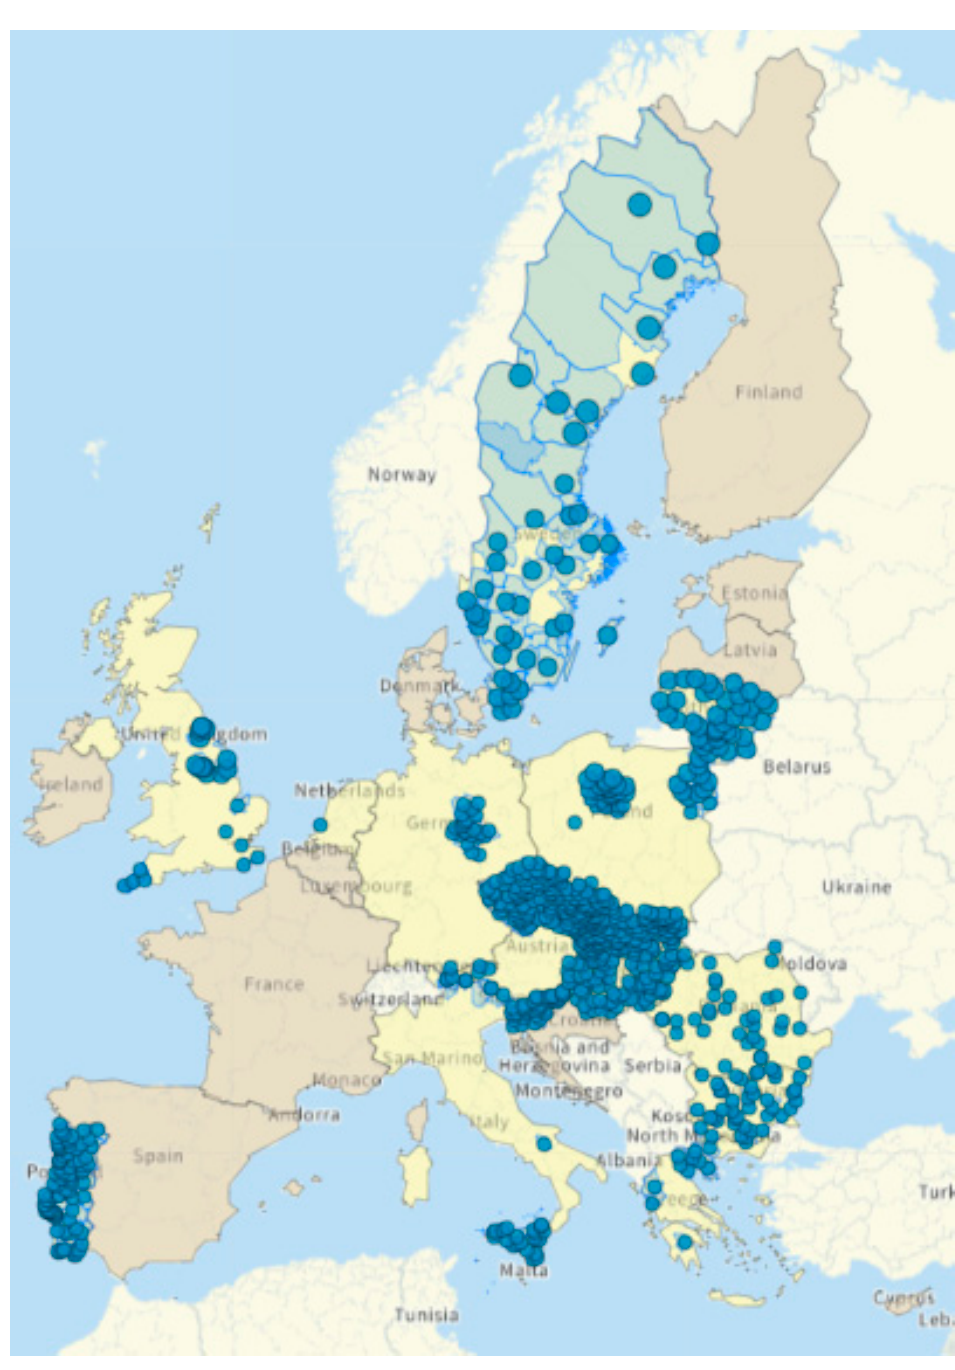
Figure A1. Map of cohesion policy-funded CLLD LAGs in 2014–20 [13].